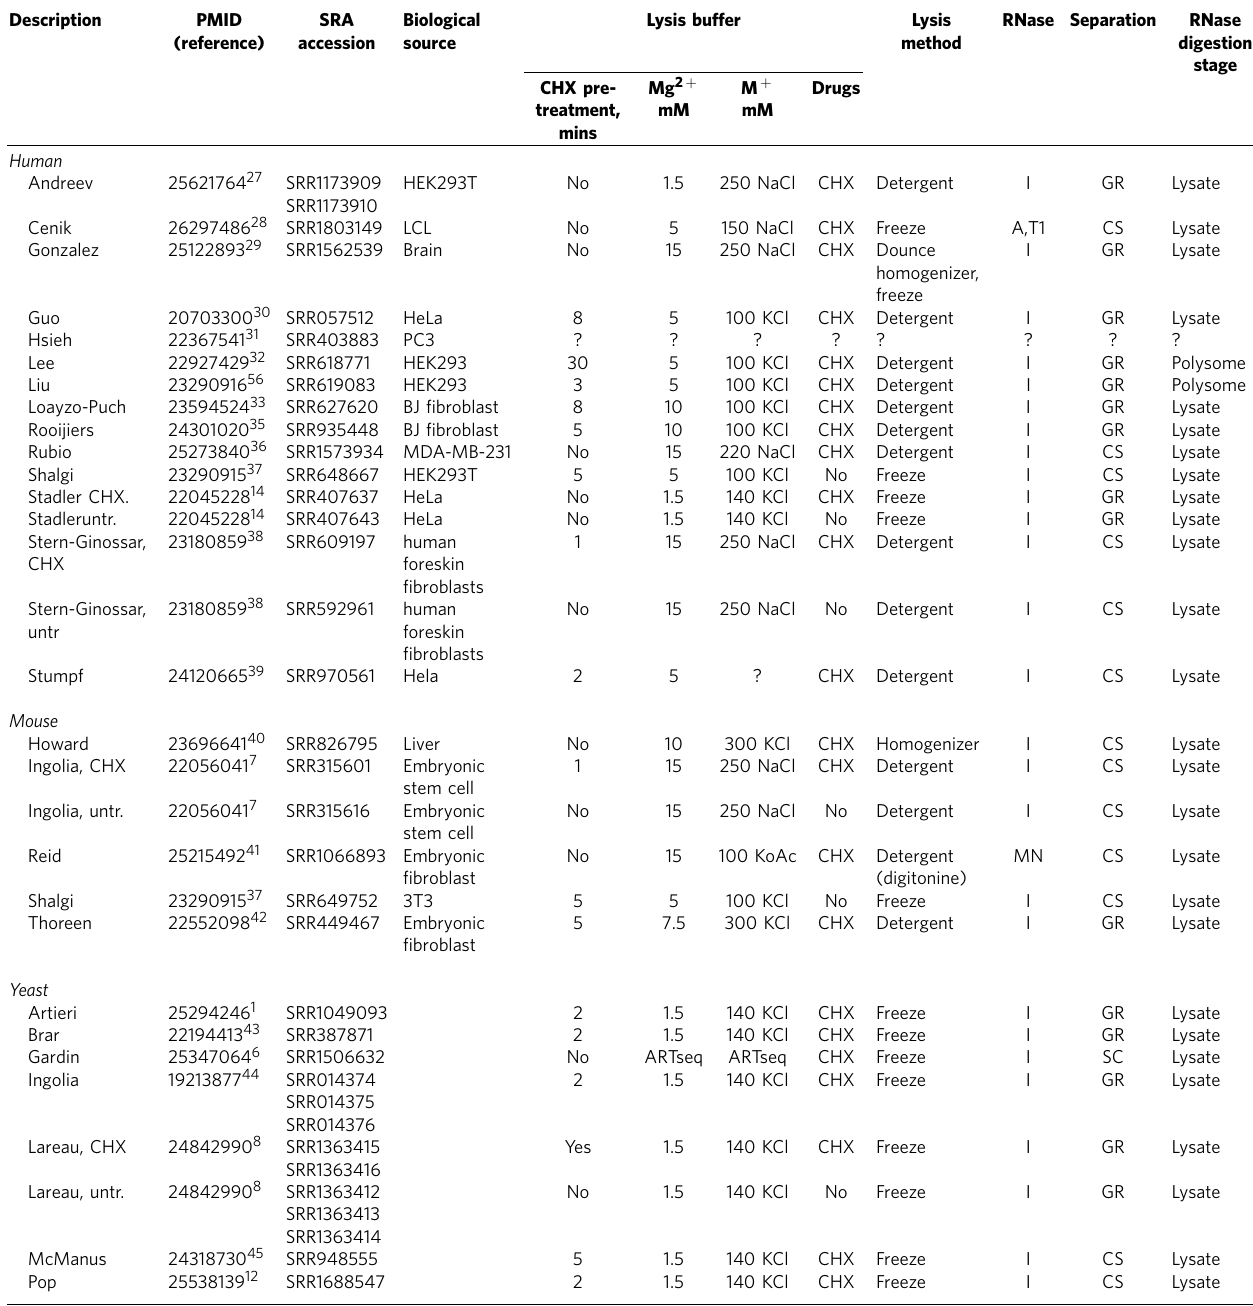
Table 1 | Ribosome profiling protocol conditions for the studies described in this work.